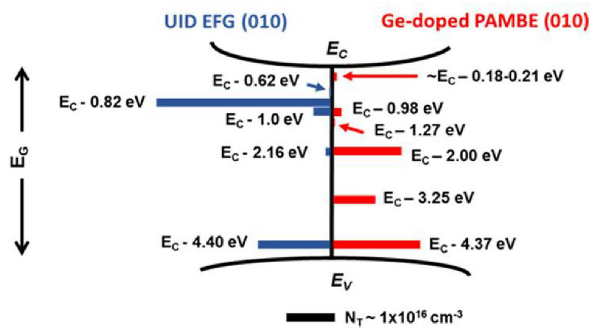
Fig. 12 Summary of the distribution (energy levels and concentra- tions) of deep-level defects for a EFG-grown (010) β -Ga strate and b MBE-grown Ge-doped (010) β -Ga The horizontal bars represent the concentration of each trap state, drawn to the scale of 1 × 10 16 cm –3 as indicated by the black